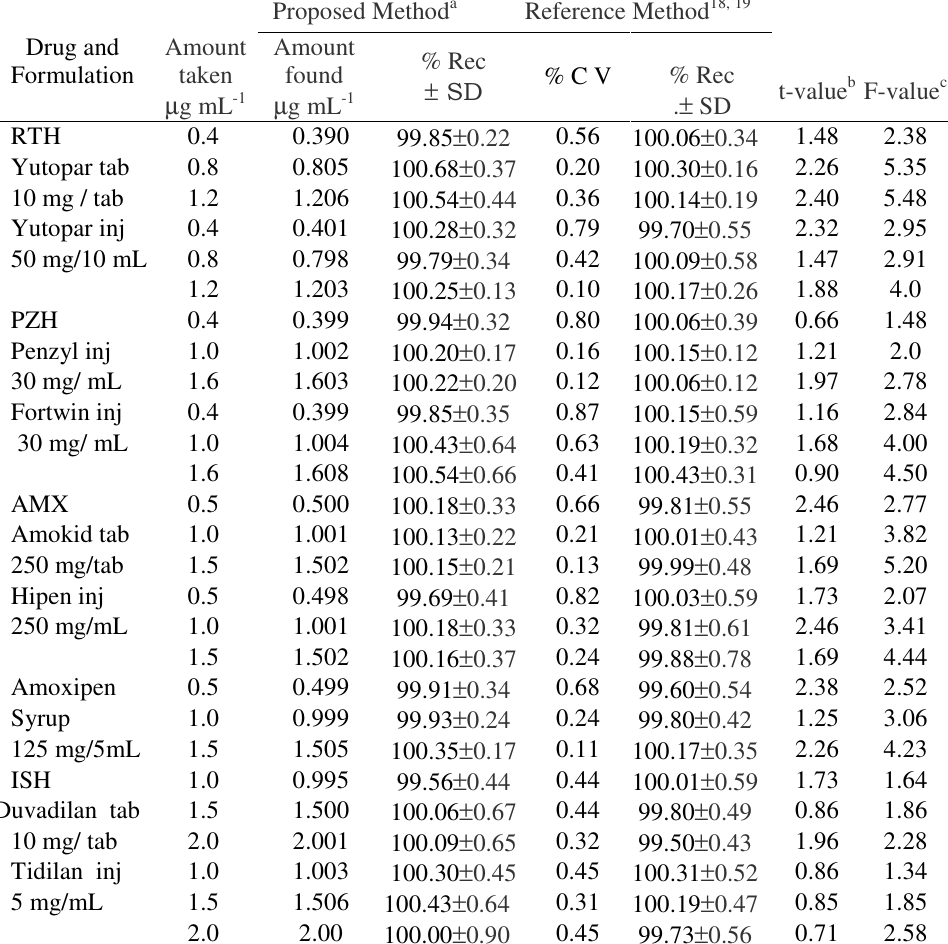
Table 1. Results of assay of RTH, PZH, AMX and ISH in dosage